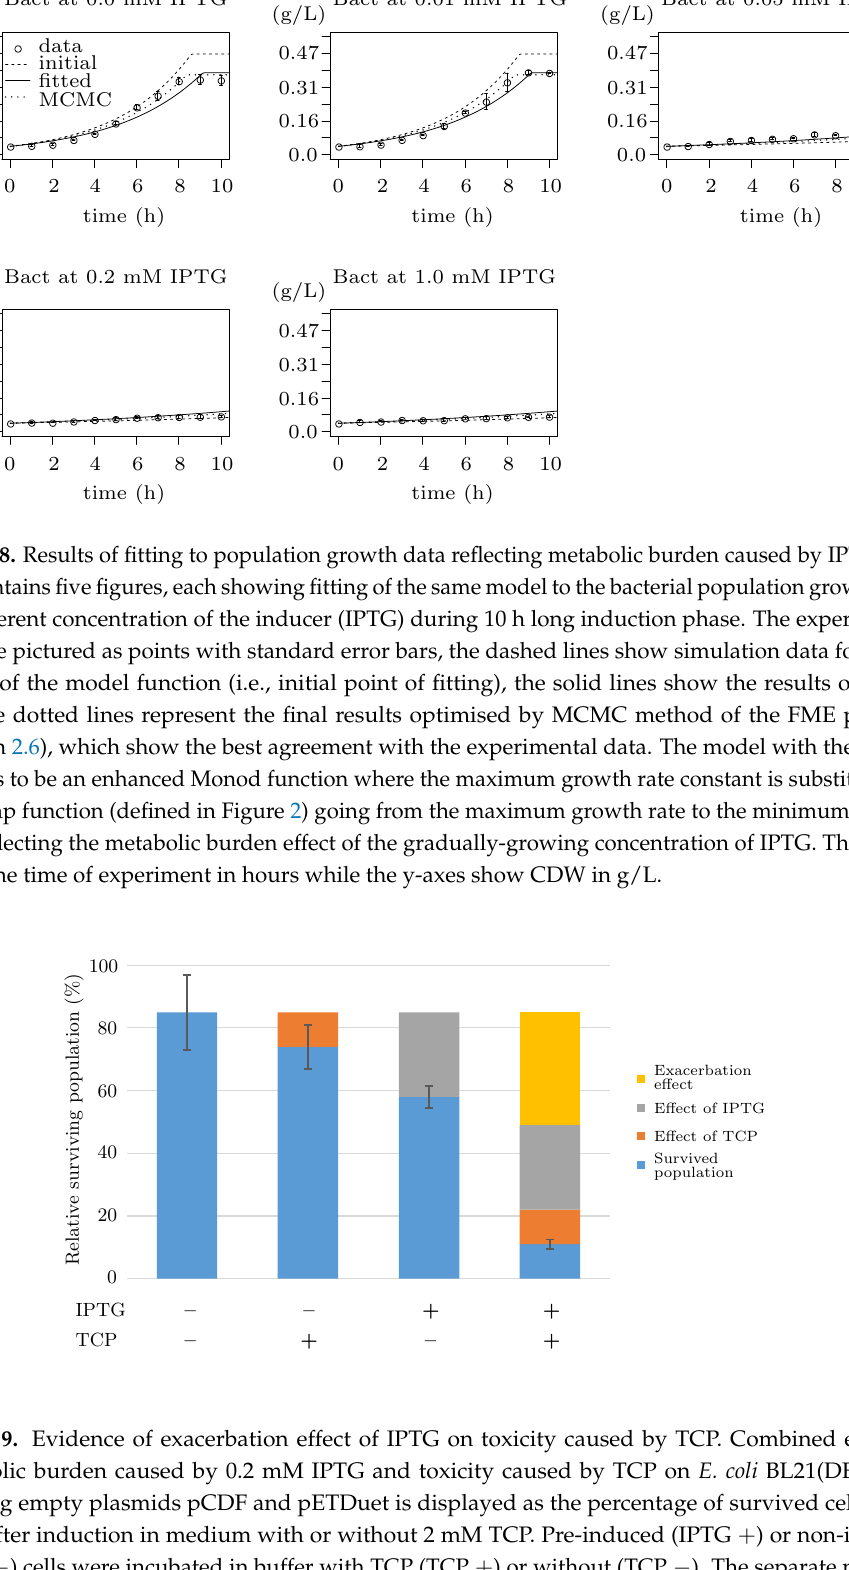
). The separate negative −